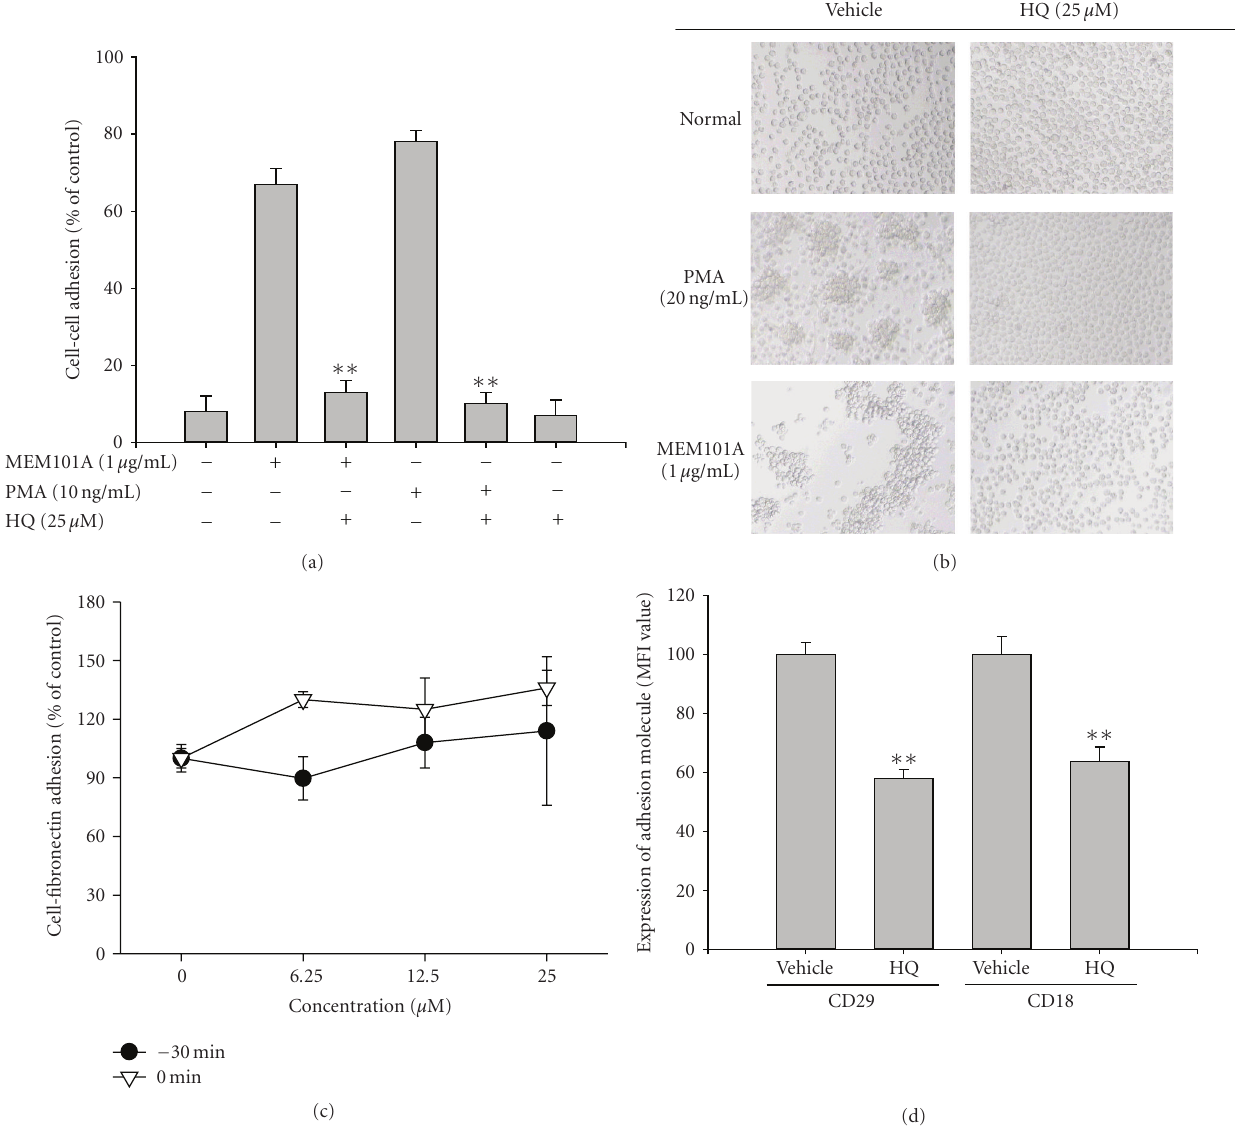
Figure 8: E ff ect of hydroquinone on cell-cell or cell-fibronectin adhesion events and surface levels of integrins (CD18 and CD29). (a) and (b) U937 cells (1 × 10 6 ) were incubated with indicated concentrations of HQ (hydroquinone) in the presence or absence of a proaggregation (activating) antibody against CD29 (MEM101A (1 μ g/mL)) for 2 hours. The extent of cell-cell aggregation was determined by quantitative cell-cell adhesion assay as described in Materials and Methods. (b) Images of cells in culture were obtained using an inverted phase contrast microscope attached to a video camera. (c) U937 cells pretreated with hydroquinone were seeded on fibronectin (50 μ g/mL)-coated plates and further incubated for 3 hours. Attached cells were determined by crystal violet assay, as described in Section 2. (d) U937 cells were incubated with hydroquinone (12.5 μ M) for 3 hours. The surface expression of adhesion molecules (CD18 and CD29) was determined by flow cytometric analysis as described in Section 2. ∗∗ p < . 01 represents significant di ff erence as compared to